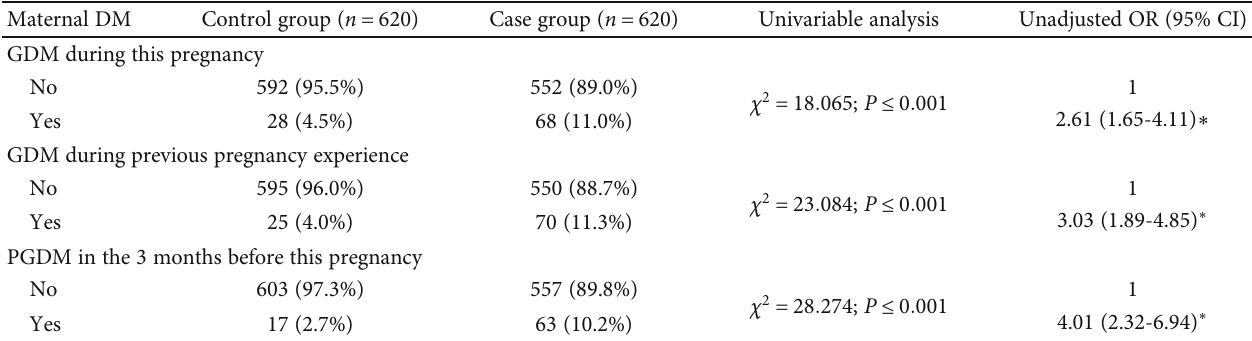
Table 2: Univariate analysis of maternal DM and o ff spring CHD.